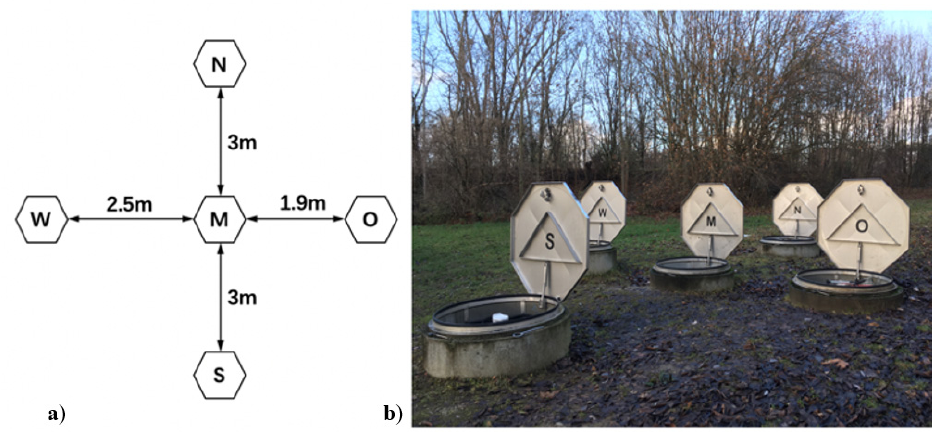
Figure 3. The test site well network: ( a ) well arrangement and ( b ) field view.